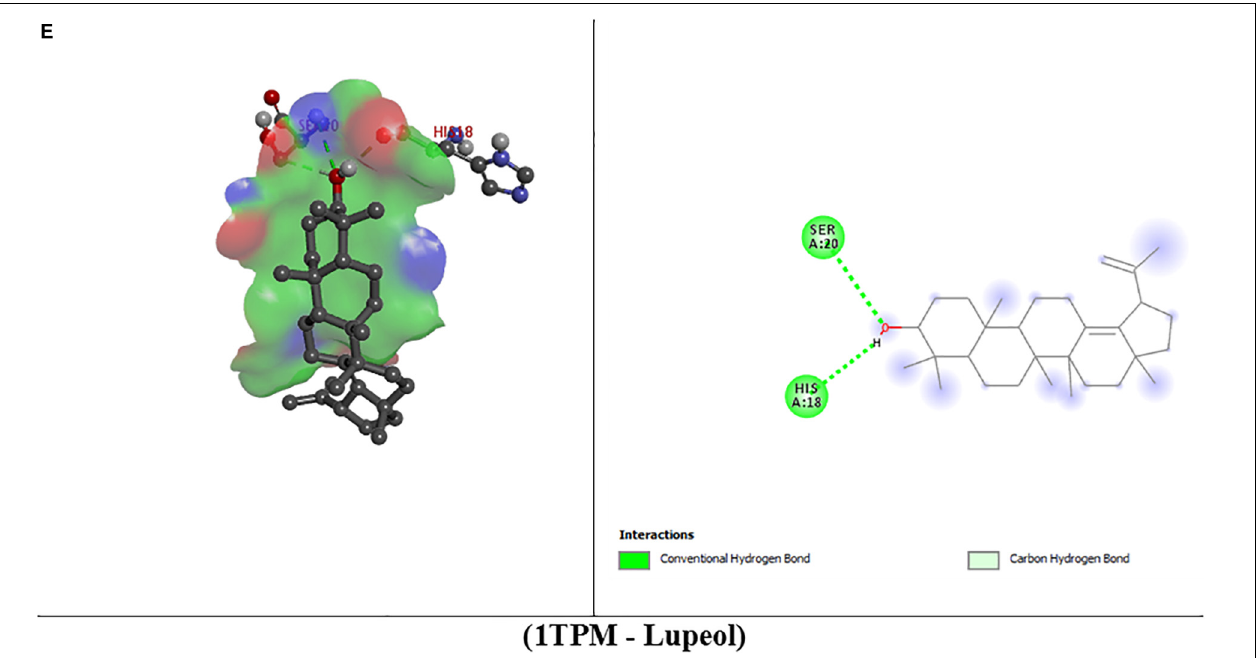
FIGURE 4 | 3D and 2D presentations of the best key interactions in the binding pocket for selected ligands and receptors where panel (A) represents the interaction of mu-opioid receptor-Gi protein complex and lupeol, panel (B) denotes celecoxib bound at the COX-2 active site and betulin, panel (C) denotes microsomal prostaglandin E synthase 1 and quercetin, panel (D) denotes kappa-opioid receptor and betulin, panel (E) denotes the interaction of tissue plasminogen activator and lupeol,